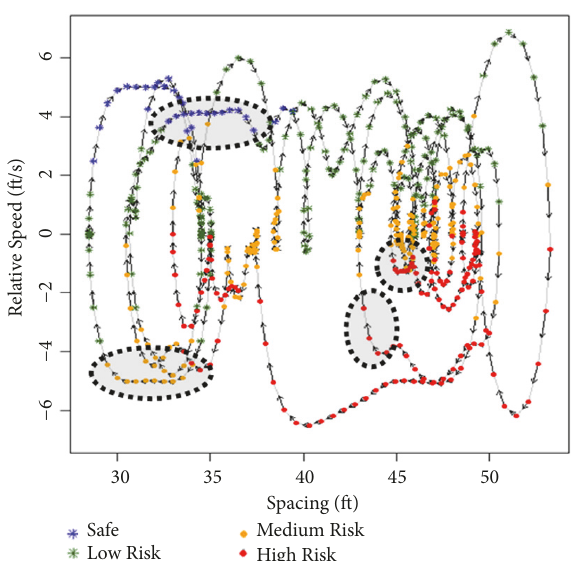
Figure 5: Collision risk estimated with the temporal spacing and relative speed